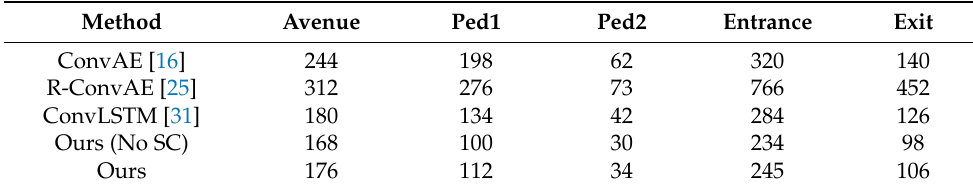
Table 3. Comparison of existing methods on execution time (per epoch). (No SC: indicates the removal of spatial constraints).